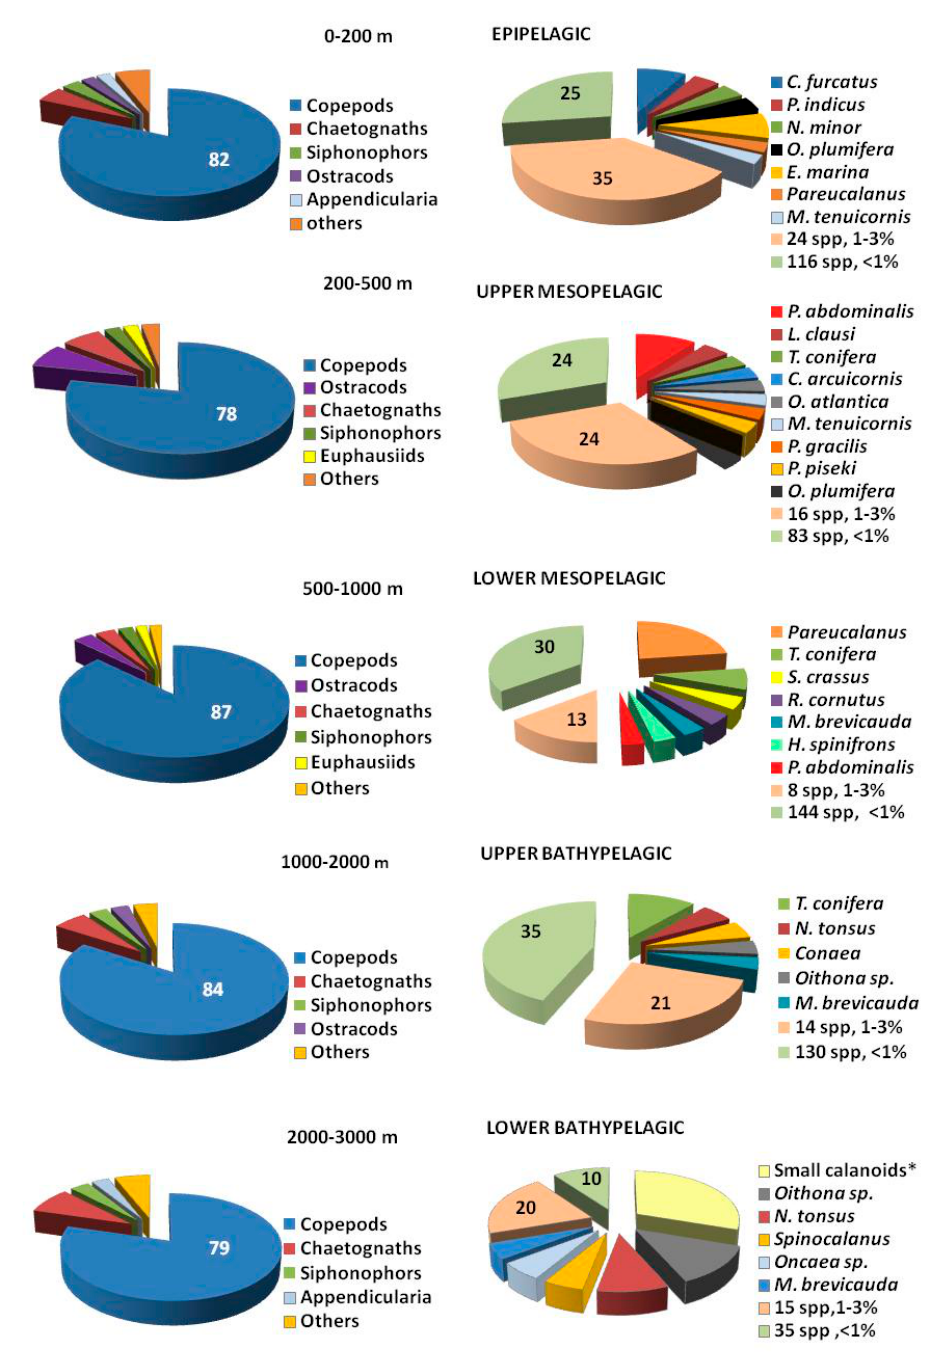
Figure 4. Relative abundance of main zooplankton groups (%), and dominant copepods ( Clausocalanus furcatus, C. arcuicornis, Paracalanus indicus, Nannocalanus minor, Neocalanus tonsus, Euchaeta marina, Mesocalanus tenuicornis, Subeucalanus crassus, Metridia brevicauda, Heterorardhus spinifrons, Rhincalanus cornutus, Oithona plumifera, O. atlantica, Pleuromamma abdominalis, P. gracilis, P. piseki, Lucicutia clausi, Triconia conifera and small calanoids* as possible contaminants) found at each depth layer (averaged across all stations sampled).